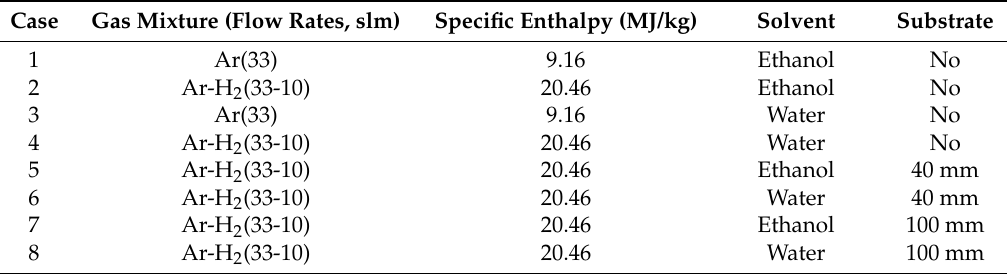
Figure 2. Different coating quality resulting from fully ( a ); and not fully atomized and vaporized droplets ( b ). Table 1. Numerical cases of the present work.